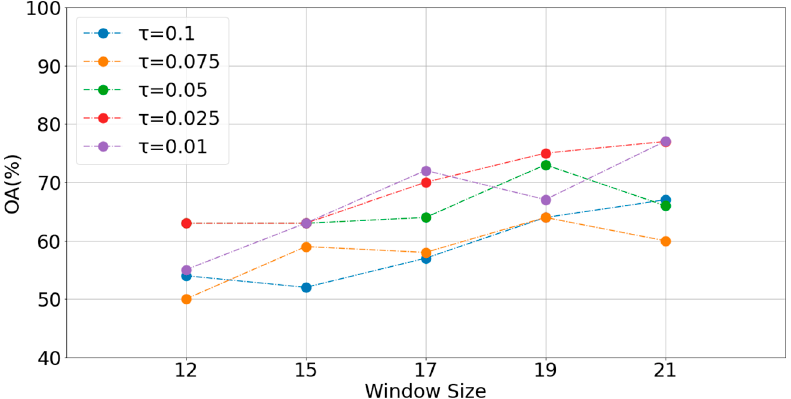
Figure 9. OA of MAAE for τ with a different size of window; τ denotes the temperature of Equation (8).